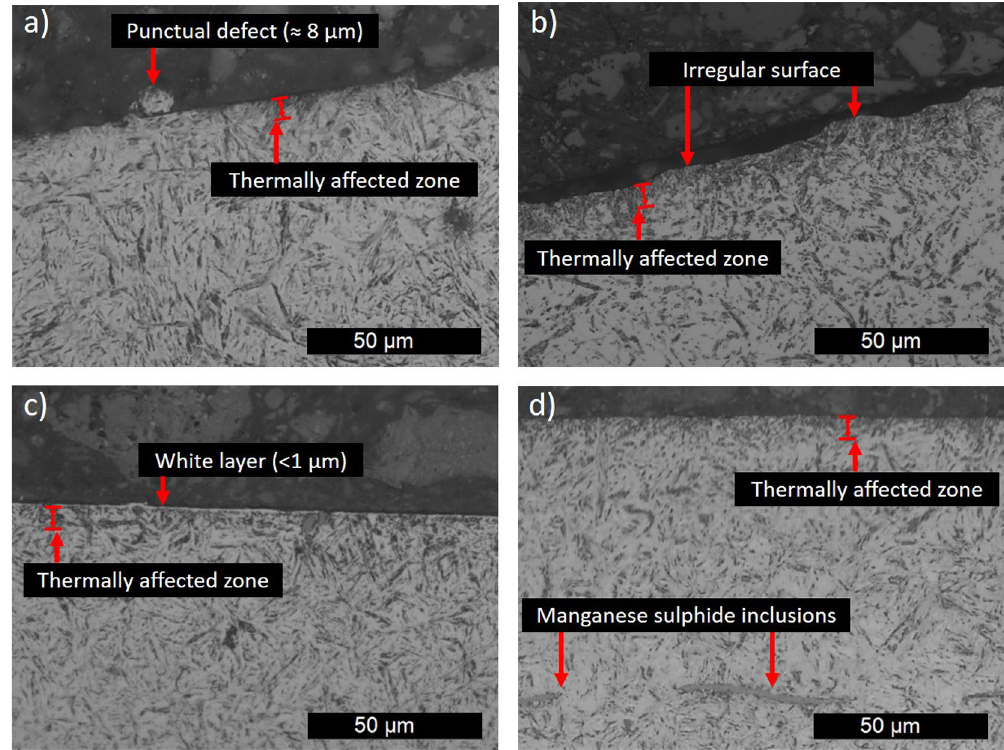
Figure 5. Summary of surface microstructure analysis: ( a ) punctual defect, ( b ) irregular surface, ( c ) white layer, and ( d ) surface without defects.